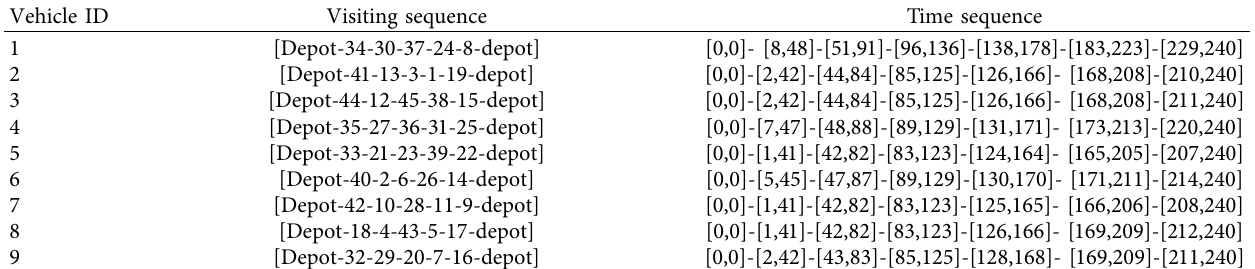
Table 12: Initial routing plan demonstration for Case 1 (45 physical nodes).